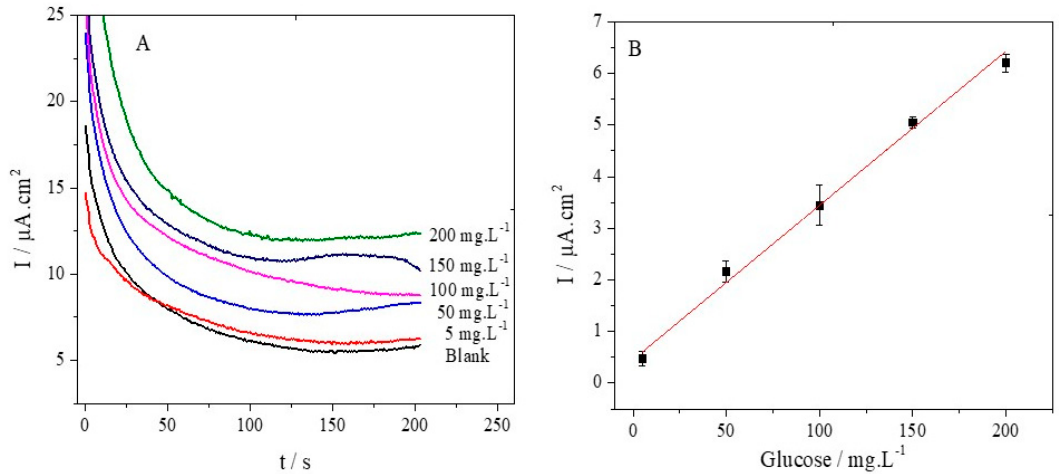
Figure 4. Chronoamperometric analysis for glucose quantification: ( A ) Chronoamperometry with different concentrations of glucose. Applied potential: +0.3 V vs. Ag/AgCl. ( B ) Calibration curve taken with the last 100 s of each chronoamperometry. Equation: I = 3.11 × 10 − 9 Glucose + 4.75 × 10 − 8 ; R 2 = 0.9931; p < 0.05.